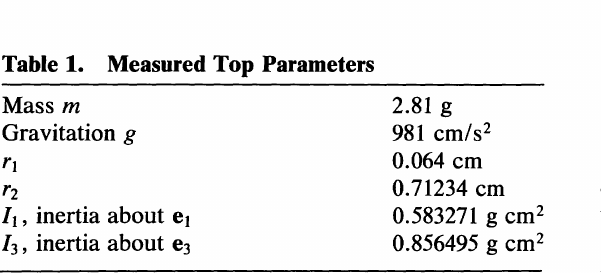
Table 1. Measured Top Parameters